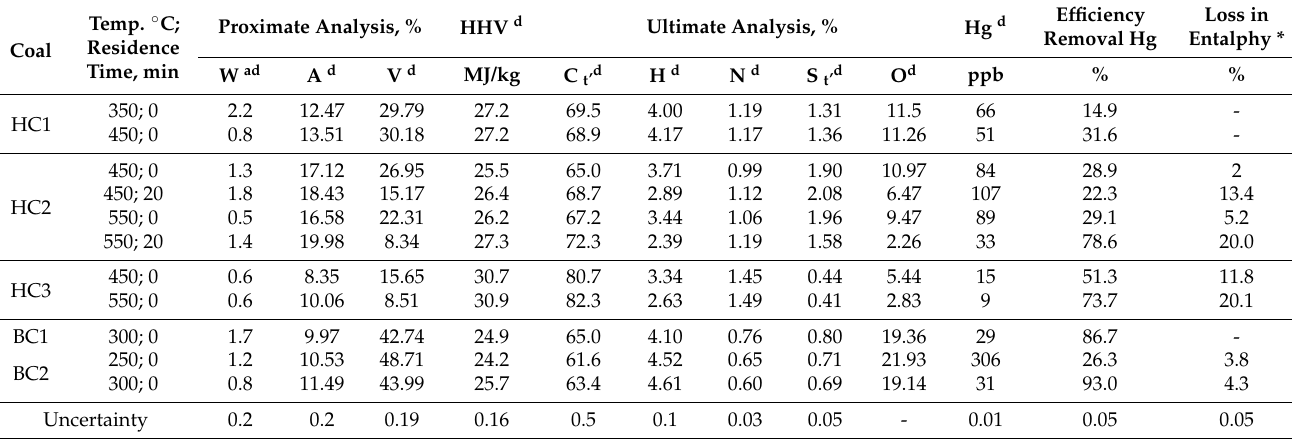
Table 5. Refined fuel